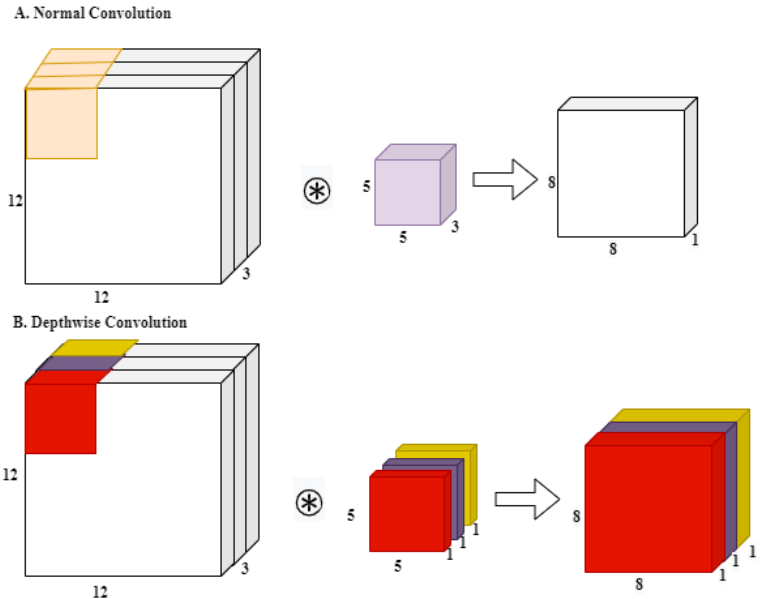
Figure 4. ( A ) shows a normal convolution with 8 × 8 × 1 output and ( B ) shows a depthwise convolu- tion with three kernels to get an image with 8 × 8 × 3 image.